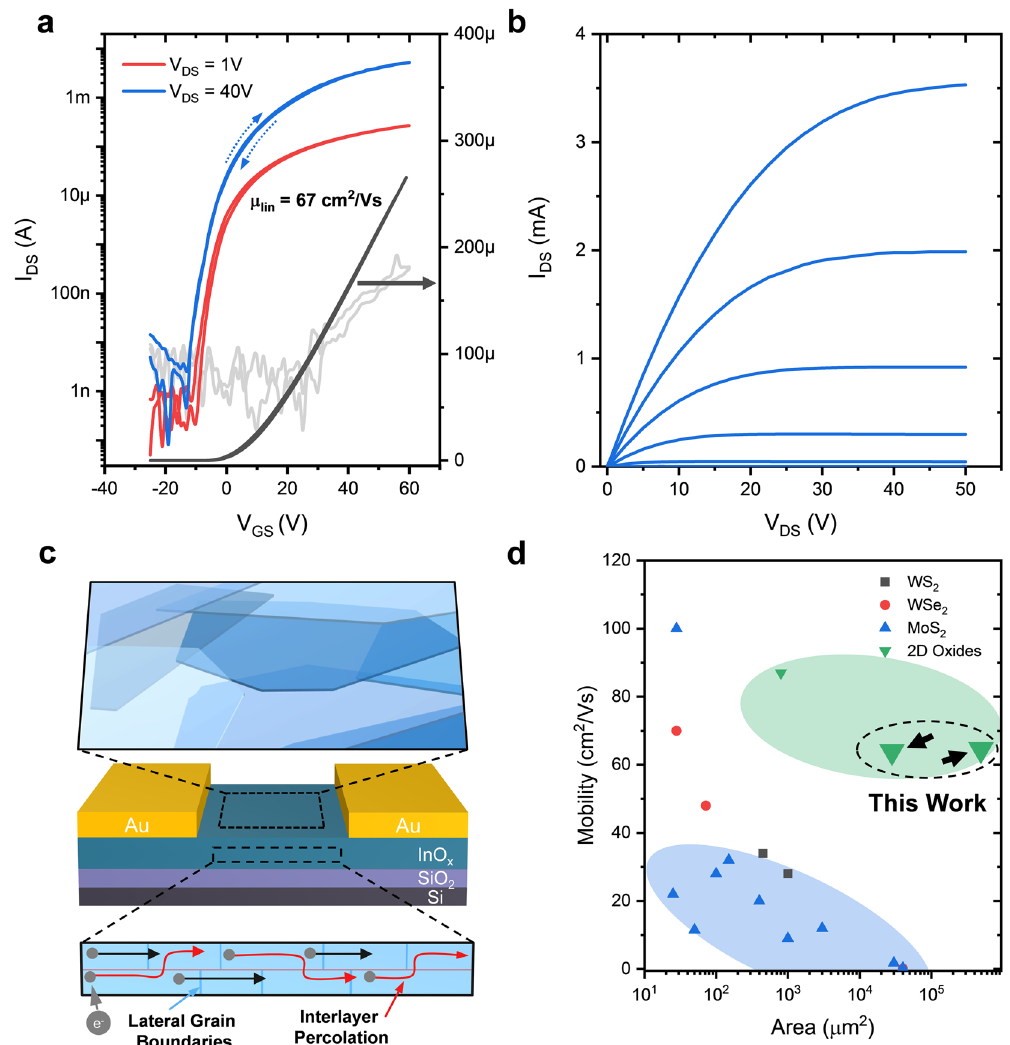
Fig. 2 2D InO x transistor characteristics and 2D material benchmarking. a Linear and saturation transfer curves for champion bilayer 2D InO x printed transistor postannealed at 250 °C. b Output curves for champion device with Vgs = − 10 V to 40 V in 10 V steps. c Schematic of device architecture with overlapped 2D bilayer grain structure leading to ef fi cient interlayer electronic transport and high electron mobility. d . Mobility comparison between 2D channel materials as a function of device area reported in